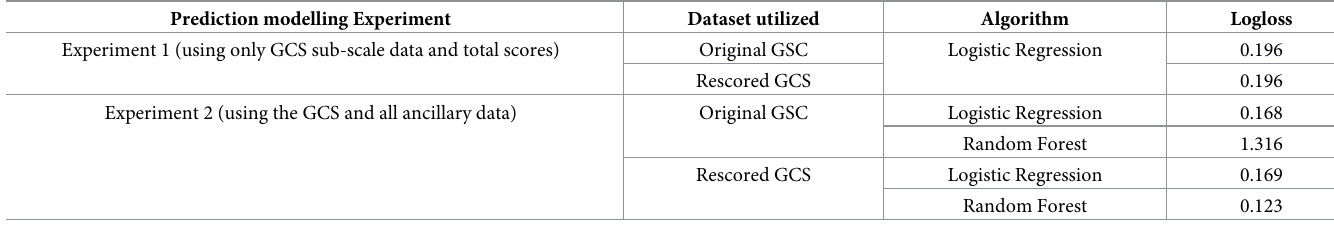
Table 6. Prediction modelling (logloss) results using the original GCS sub-scale scores compared to the re-scored versions. Prediction modelling